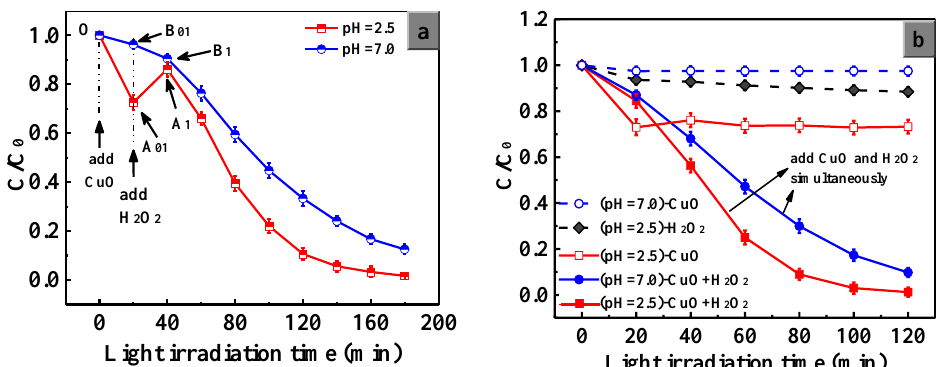
Figure 8. The catalytic performance of the porous CuO powders in the degradation of MO with different initial pH values: CuO and H 2 O 2 were added ( a ) orderly, ( b ) simultaneously under light